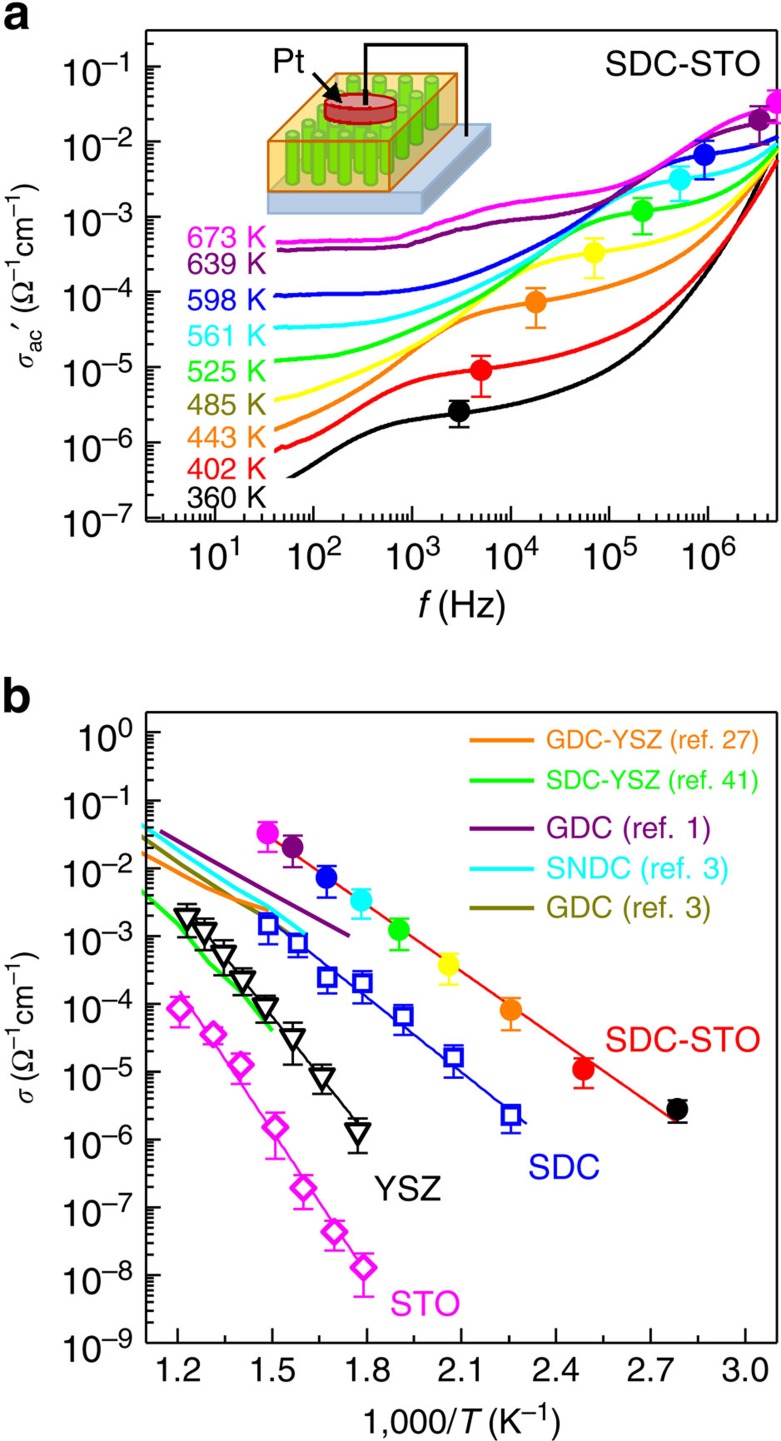
Transport properties of nanoscaffold SDC–STO films.(a) Frequency dependence of the real part of ac conductivity σac′ measured in the nanoscaffold SDC–STO film with variation of temperature. The ionic conductivity σ is defined from the plateaus of σac′, as indicated by solid circles. The error bars in the solid circles represent the possible spread in plateau positions. (b) Temperature dependence of σ for the nanoscaffold SDC–STO film. For comparison, we include those for the plain SDC, YSZ and STO films that we grew. The error bars of the σ values represent the small variation of the plateaus of σac′. We also include the σ values for GDC13, Sm0.075Nd0.075Ce0.85O2−δ(SNDC)3, GDC–YSZ nanocomposites27 and SDC–YSZ multilayers42 reported in the literature.